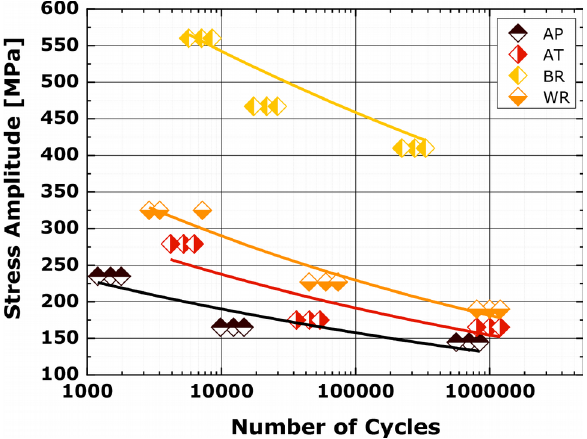
Figure 8. High cycle fatigue life for as printed (AP), as turned (AT), as burnished best result (BR) and worst result (WR) (Sanguedolce et al,